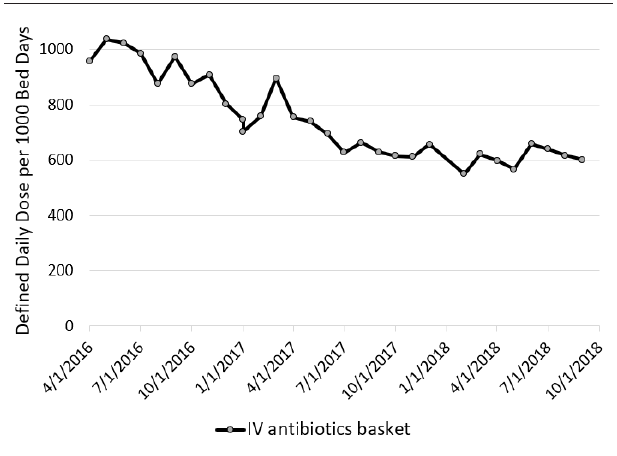
Figure 2b: Antibiotic Usage During the Post-BB and ASP Period for the Five Most Commonly Prescribed